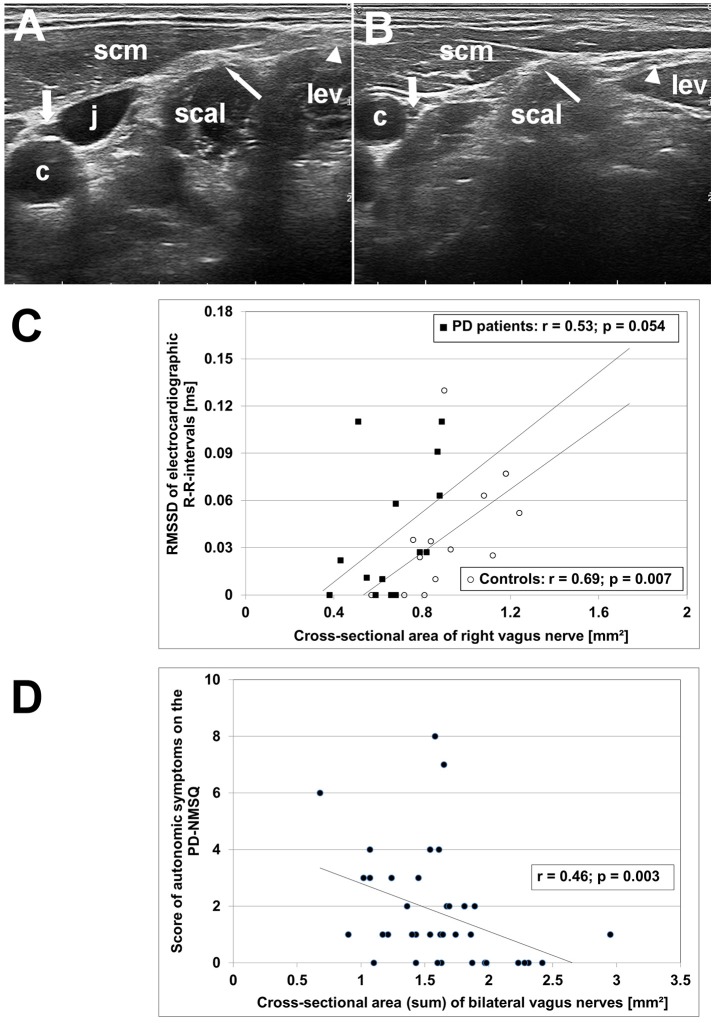
High-resolution ultrasonography (HR-US) findings of vagus, spinal accessory and phrenic nerves in PD patients and controls. (A) Axial HR-US scan of the lateral cervical region at the midneck level in a healthy elderly woman. The vagus nerve (thick arrow) is visualized in the carotid sheath between the common carotid artery (c) and the jugular vein (j). The phrenic nerve (thin arrow) is located superficial to the scalene muscle (scal) underneath the sternocleidomastoid muscle (scm). The spinal accessory nerve (triangle) is identified superficial to the levator scapulae muscle (lev). (B) Axial HR-US scan of the lateral cervical region in a PD patient. Compared to the control subject shown in (A) the vagus nerve (thick arrow) shows a clearly reduced caliber. The phrenic nerve (thin arrow) and the spinal accessory nerve (triangle) are of similar size as in age-matched controls. (C) Diagram showing the correlation between RMSSD, an electrocardiographic parameter reflecting vagal cardiac innervation, and caliber of right vagus nerve in PD patients (°) and age-matched controls (■). (D) Diagram showing the correlation between the sum score of autonomic symptoms on the PD Non-Motor Symptoms Questionnaire (calculated from items 1, 3, 4, 5, 6, 7, 8, 11, 19, 20, 28) and bilateral vagus nerve caliber in the combined group of PD patients and age-matched controls.